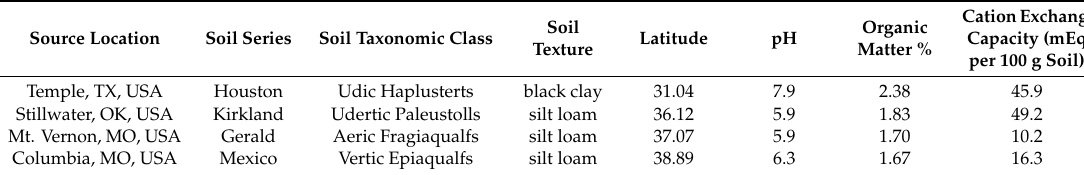
Table 1. Locations and characteristics of soils used for inocula.